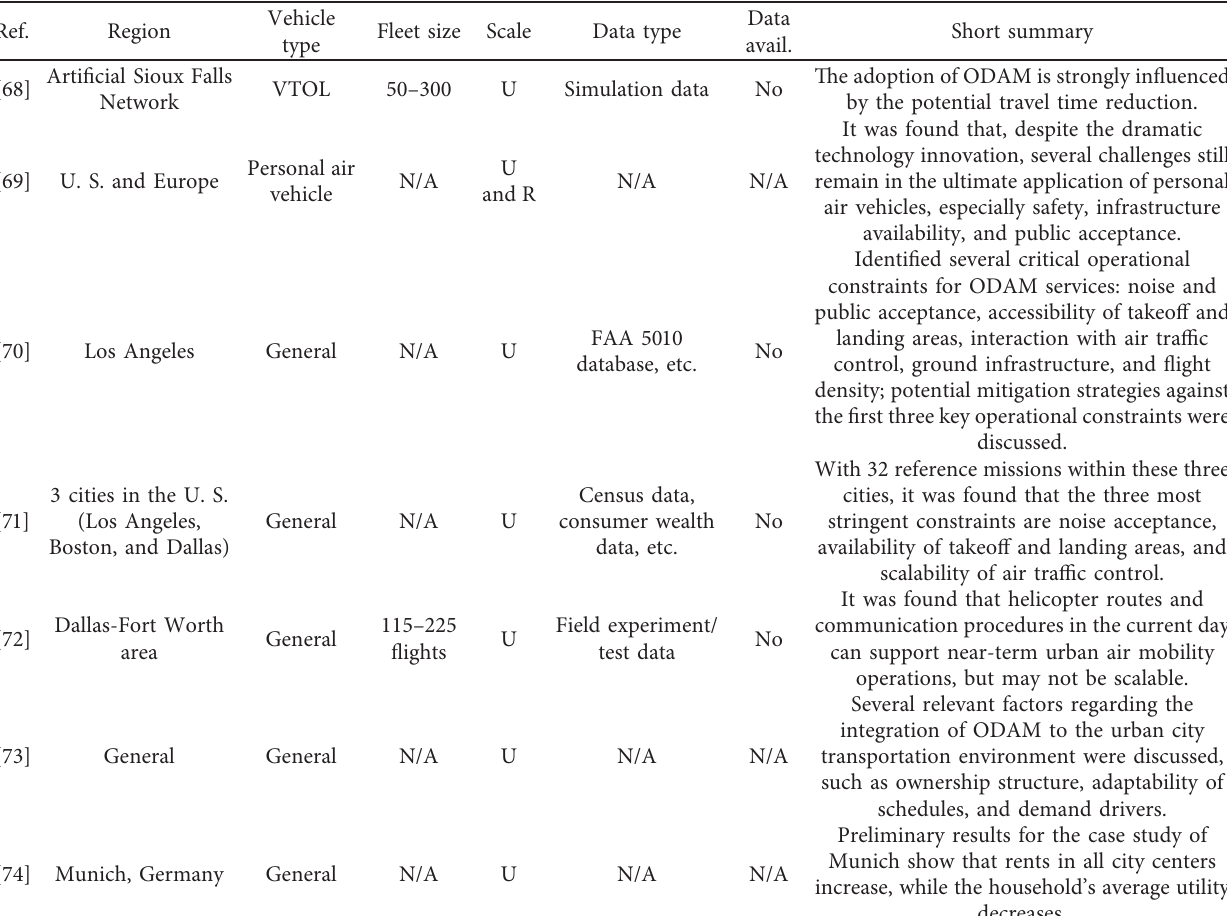
Table 4: An overview of the ODAM operational constraints’ identification.